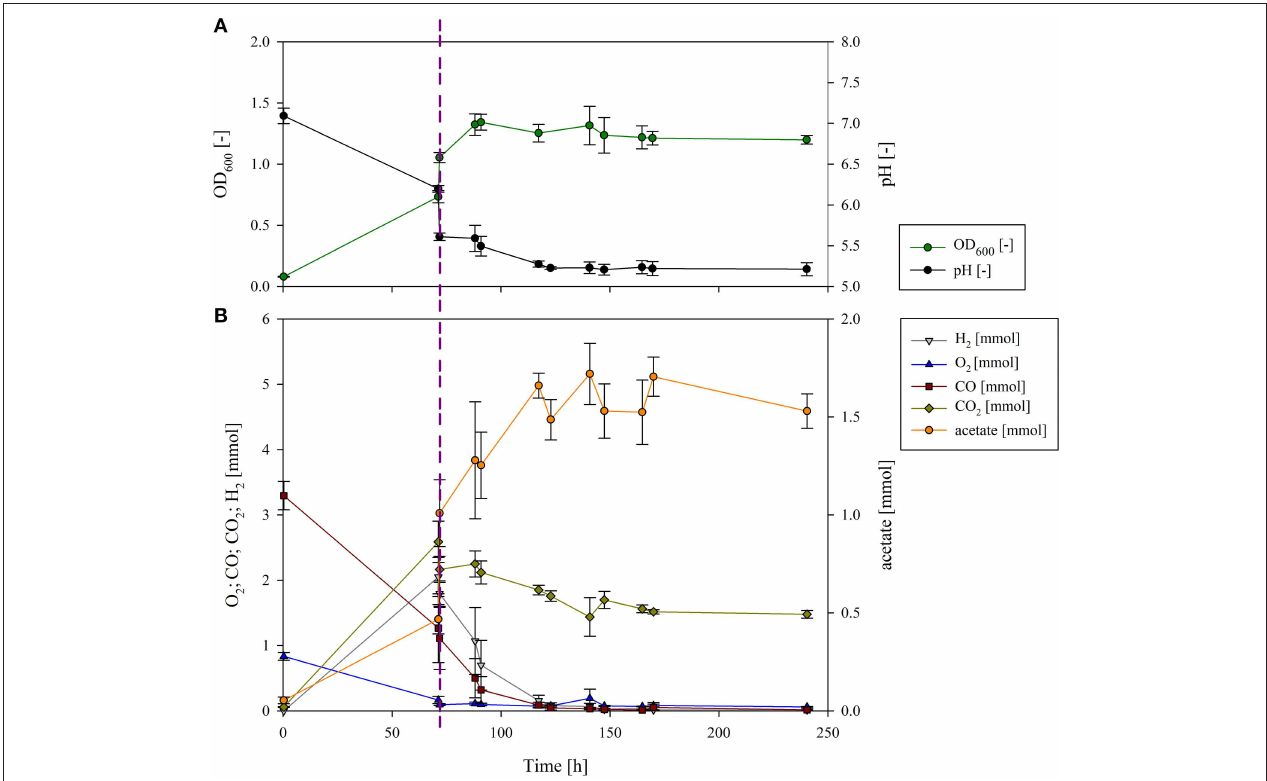
FIGURE 2 | Growth and pH (A) and gas composition and acetate production (B) of the sequential cultivation of P. thermoglucosidasius and C. ljungdahlii. The dotted line presents the inoculation of C. ljungdahlii. (A) The measured OD 600 (dark green) increased after 70h, and at the same time the pH (black) decreased due to the inoculation with C. ljungdahlii . Growth continued until 93h (23h after inoculation with the second organism), and then it plateaued. As a result of the metabolic activity, the culture broth was acidified to a pH of 5.2. (B) O 2 (blue) had already been consumed before the second phase, but some CO (dark red) was still left. After inoculation with C. ljungdahlii , CO 2 (olive), and H 2 (gray) did not accumulate any further, since they were used as building blocks by C. ljungdahlii to produce acetate